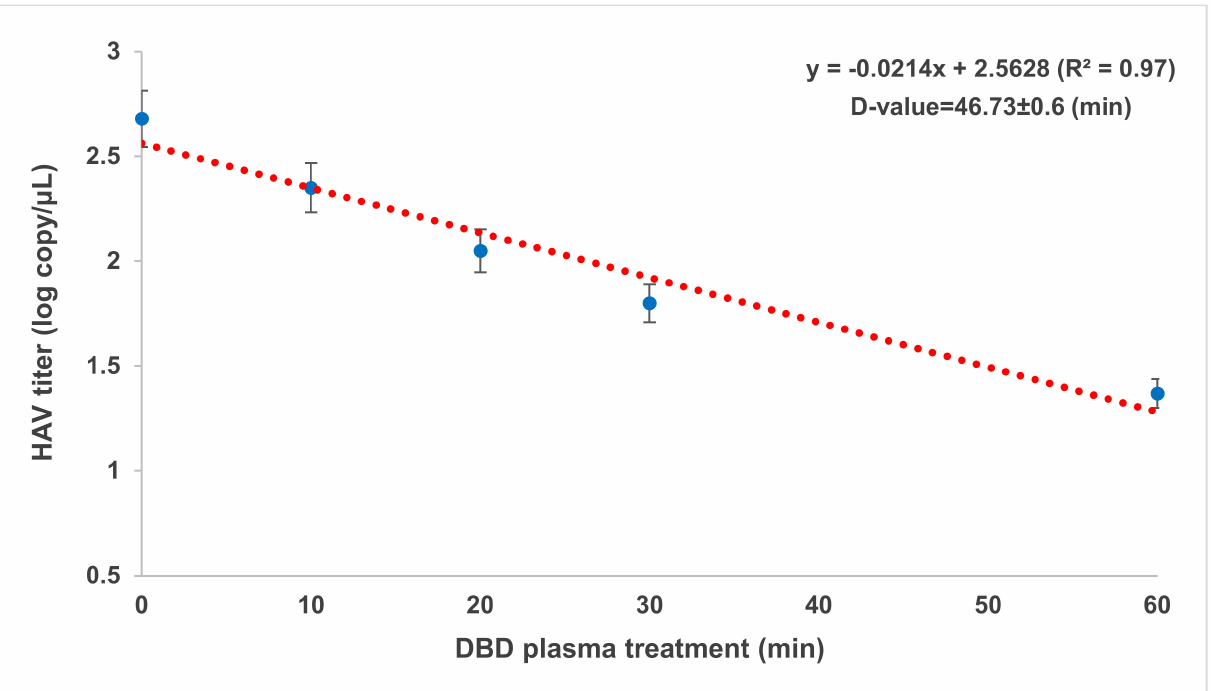
Figure 4. Fitted survival curves of HAV in oyster treated by DBDP using the first-order kinetics model. Error bars indicate the standard deviations for the mean of three samples per